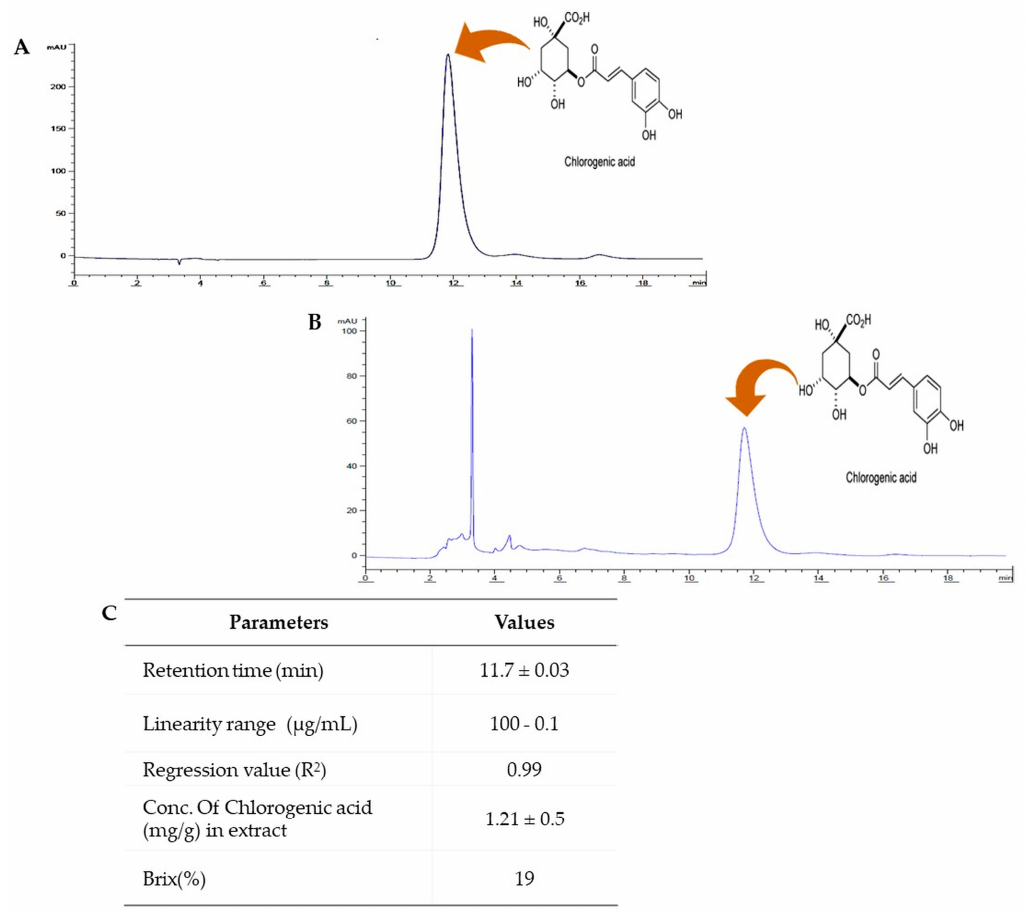
Figure 3. HPLC analysis of Pyrus ussuriensis Maxim ethanol (50%) extract. ( A ) The chromatogram obtained by HPLC analysis of the chlorogenic acid standard solution and ( B ) PUE. ( C ) The table shows the different parameters obtained during the method validation procedure and chlorogenic acid content determination using ACN and 0.5% aqueous phosphoric acid (11.5:88.5 ratio, V/V) as the mobile phase, an injection volume of 20 µ L, a 40 ◦ C column temperature, and a wavelength of 327